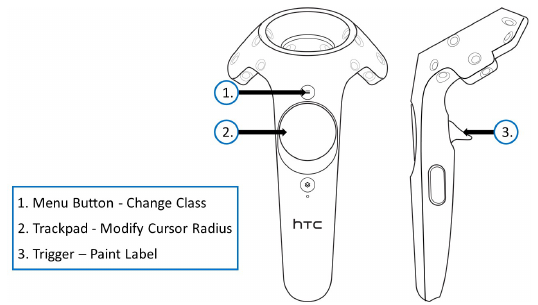
Figure 6. Schematic of the VR functionnalities associated to the right